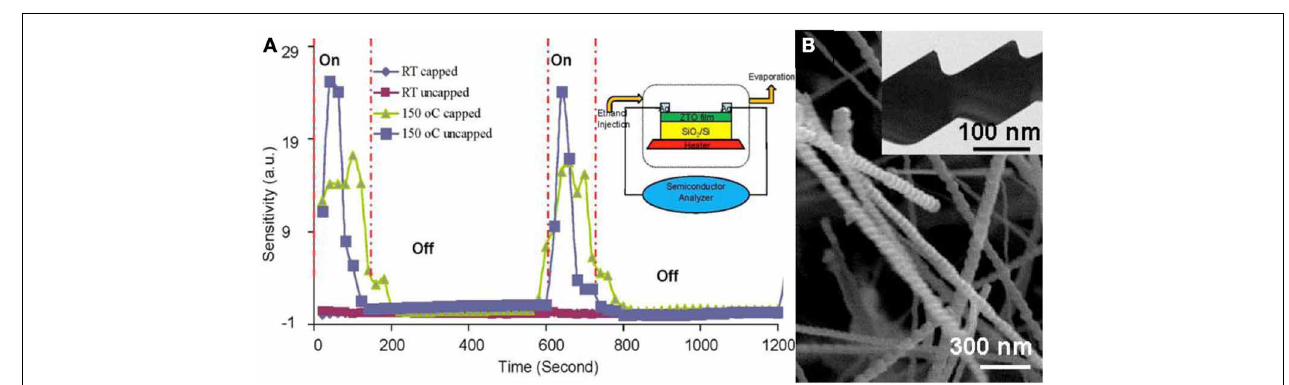
FIGURE 7 | Ethanol sensor configuration and property based on Ag 2 O/Zn 2 SnO4 hierarchical composite nanowires prepared by vapor solid solid method. (A) Ethanol sensor configuration and gas sensing performance of Ag 2 O/Zn 2 SnO 4 hybrid